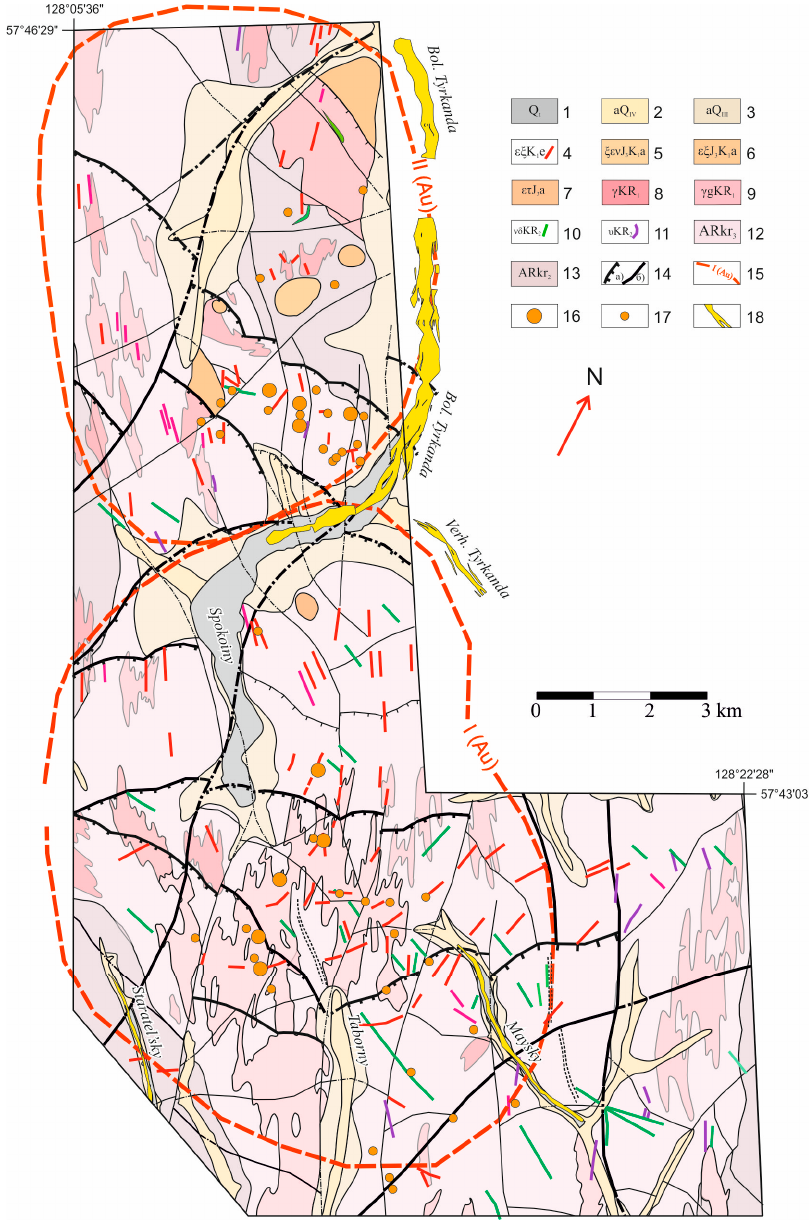
Figure 1. Schematic map of geological structure of the Spokoininsky ore cluster [1] with changes: 1—technogenous formations: rewashed deposits of prospectors polygons; 2—Quaternary: channel and low fl oodplain alluvium; 3—Upper Quaternary deposits: fl oodplain, channel, above- fl oodplain terrace alluvium, and fl uvioglacial deposits; 4—dikes of alkaline and alkaline–earth syenites; 5–7— stocks: 5—alkaline–earth syenite, 6—pulaskites, laurvikites, and nordmarkites, 7—alkaline trachytes; 8—biotite, muscovite, and garnet granites, hypersthene–amphibole microcline granites, enderbites, and granites undivided; 9—variously hybridized granitized rocks and granite gneisses;